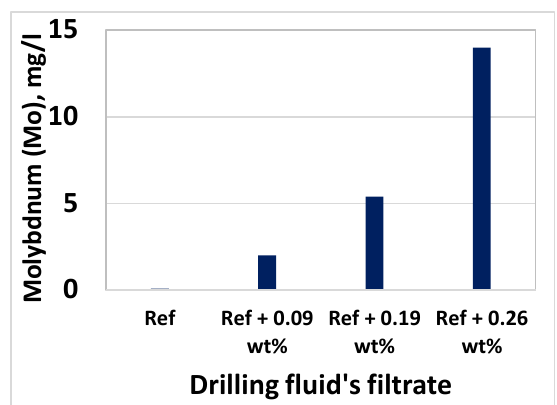
Figure 19. Mo in the filtrates of drilling fluids.